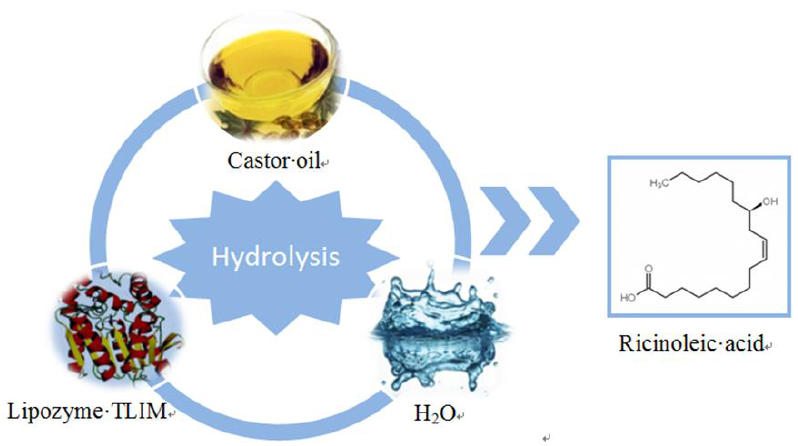
Figure 1. Enzymatic hydrolysis of castor oil (CO) to prepare ricinoleic acid (RA).